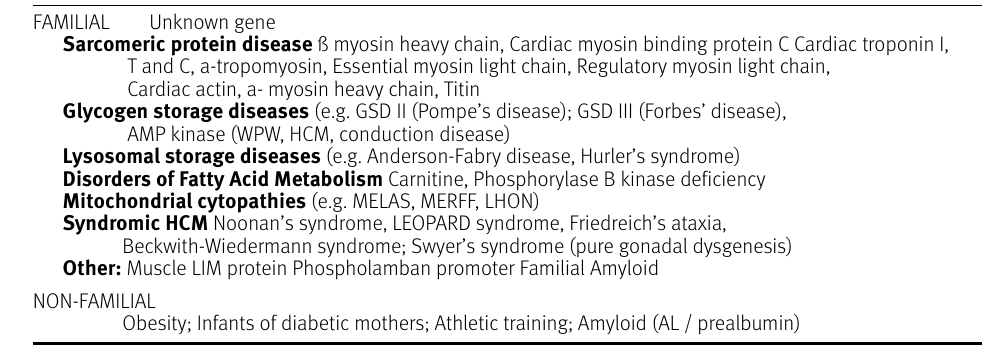
Figure 2. Classification of the cardiomyopathies – European Society of Cardiology. Modified from [8]. Table 1. Hypertrophic cardiomyopathy.